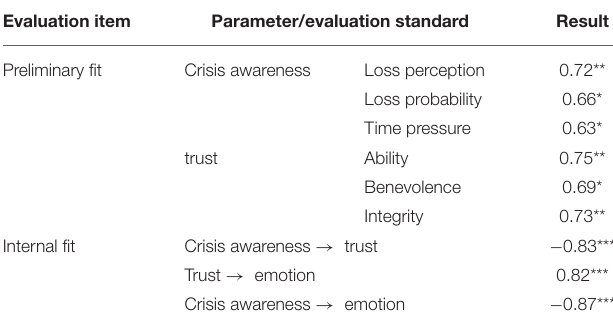
TABLE 1 | Goodness-of-fit analysis of the research model. TABLE 2 | Overall results of linear structural model